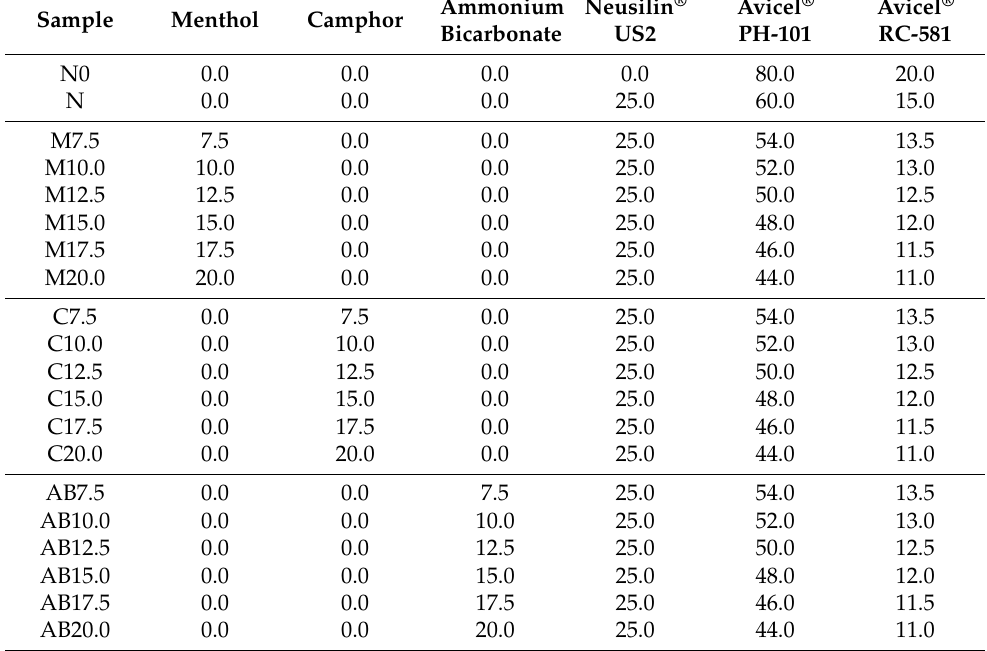
Table 1. Composition of composite pellets (%